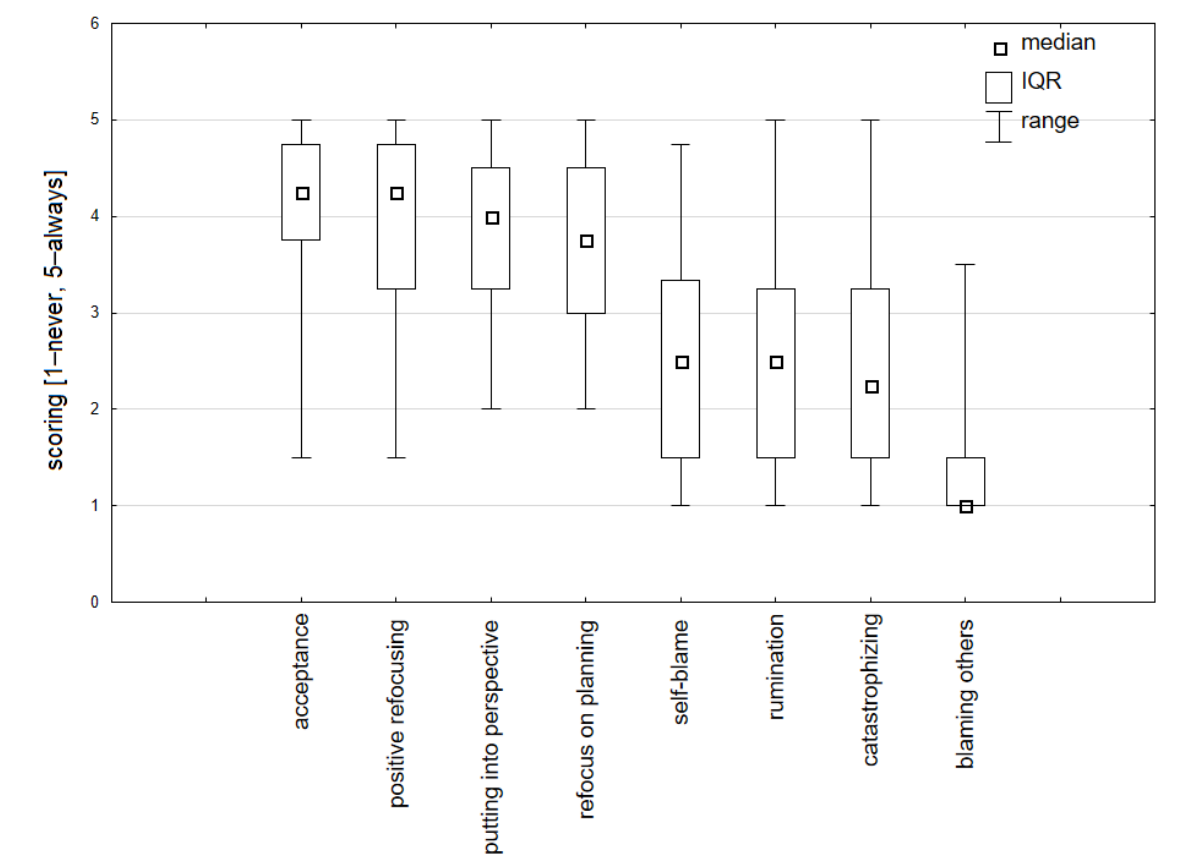
Figure 1. Cognitive strategies used by cancer patients during radical therapy.